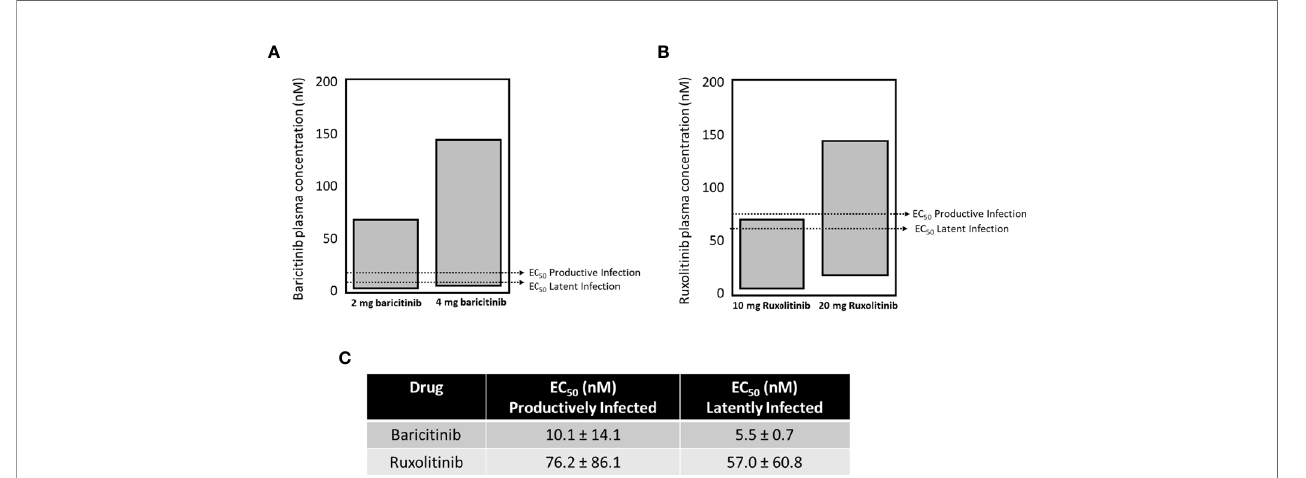
FIGURE 6 | The EC 50 for blocking seeding of productive and latent infection with baricitinib and ruxolitinib. The approved dose for chronic long-term use of baricitinib is 2 mg (USA), or 2 and 4 mg (Japan, other non-USA jurisdictions), and 4 mg is approved for hospitalized COVID-19 patients. The plasma concentrations for both doses of baricitinib fall within the range to effectively block both productive and latent infection in our single cycle model (A) . Ruxolitinib is not approved for chronic long-term use, but approved doses range within 10-25 mg (B) . Only the higher dose of ruxolitinib fell within plasma concentration ranges to block both productive and latent infection in our single cycle model (B) . Baricitinib demonstrates ~ half a log greater potency for both assays versus ruxolitinib (summarized in C ).